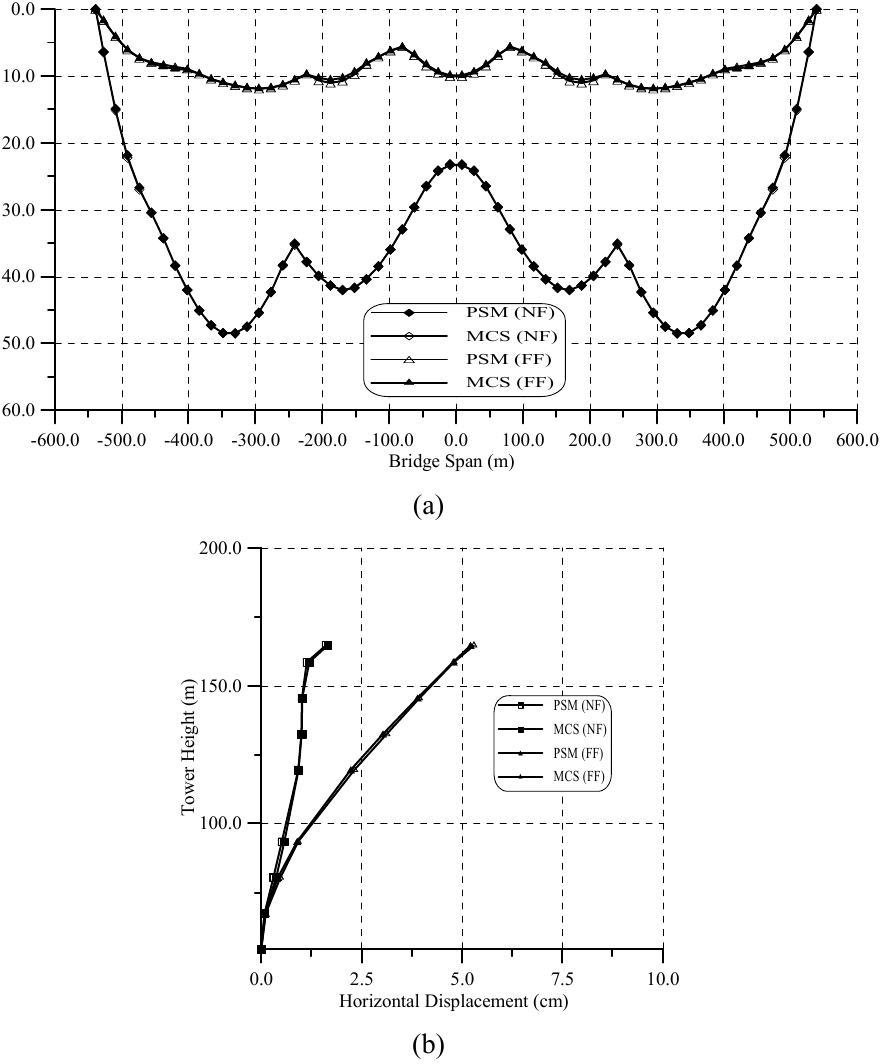
Fig. 12. Maximum sensitivity vertical displacements at the deck of Fatih Sultan Mehmet Bridge (a) and maximum horizontal displacements along Fatih Sultan Mehmet European tower (b) for random elastic modulus.